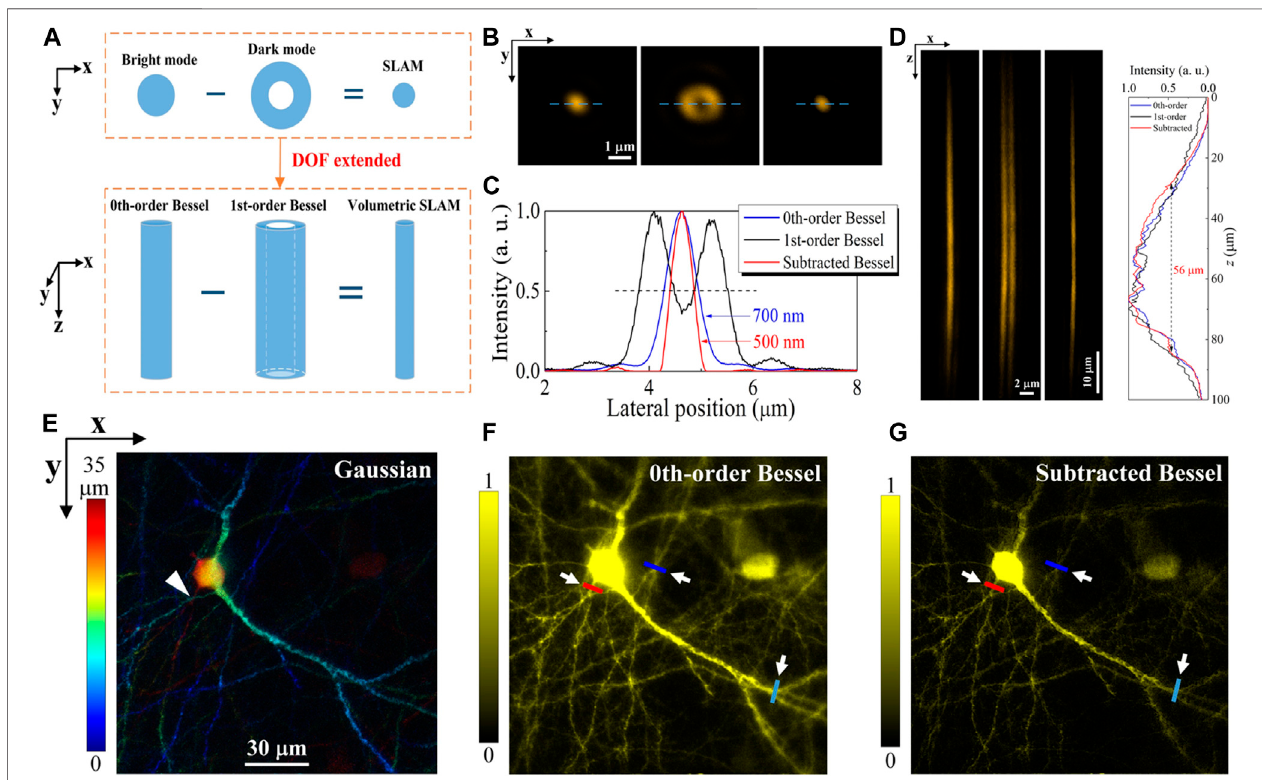
FIGURE 13 | (A) Mechanism of the conventional SLAM (top) and the v-SLAM (bottom). (B) The lateral intensity distribution of the 0th-order Bessel (left), the 1st- order Bessel (middle), and the subtraction of Bessel beams (right). (C) Linear pro fi les of the PSF in (B) . (D) PSFs of the 0th-order, 1st-order, and subtracted Bessel beams in the x - z plane. (E) Projection of the Gaussian-scanned image stacks for the mouse brain slices (color codes the depth). The images are obtained by the 0th- order Bessel beam (F) and the subtraction image (G) . The three positions with different depths ( z s (cid:2) 2, 12, and 29 μ m) are labeled in (F,G) . Reproduced with permission from OSA